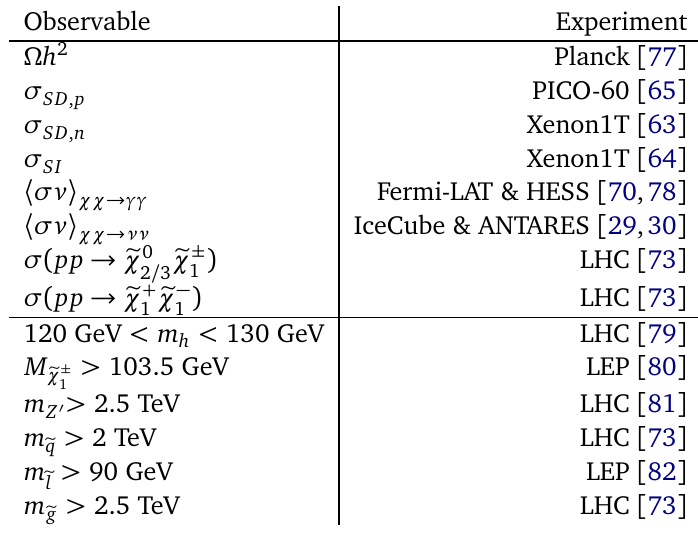
Table 2: Constraints that are imposed on all model points. The DM direct detection and the LHC production cross sections ( σ ( pp → implemented using DDCalc and Smodels respectively. The constraints on particle masses are implemented as a hard cut. Note that constraints on the sfermions and gluino masses are stricter than those provided by LHC searches, but this is done as so to guarantee that the model is not excluded by searches for coloured